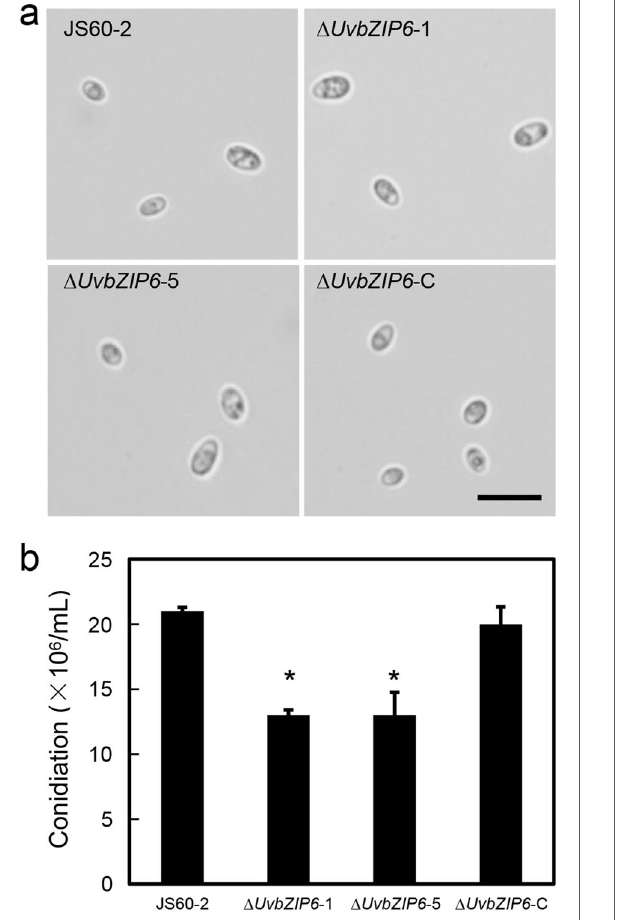
Fig. 4 Knockout of UvbZIP6 reduces conidiation in U. virens . a Conidial morphology of the WT, UvbZIP6- knockout mutants, and complemented strains. The strains were cultured in PSB at 27 °C for 7 days. Scale bar 10 μm. b Conidiation capacity of the tested = strains. Error bars represent standard deviation, and asterisks denote a significant difference ( P < 0.05)